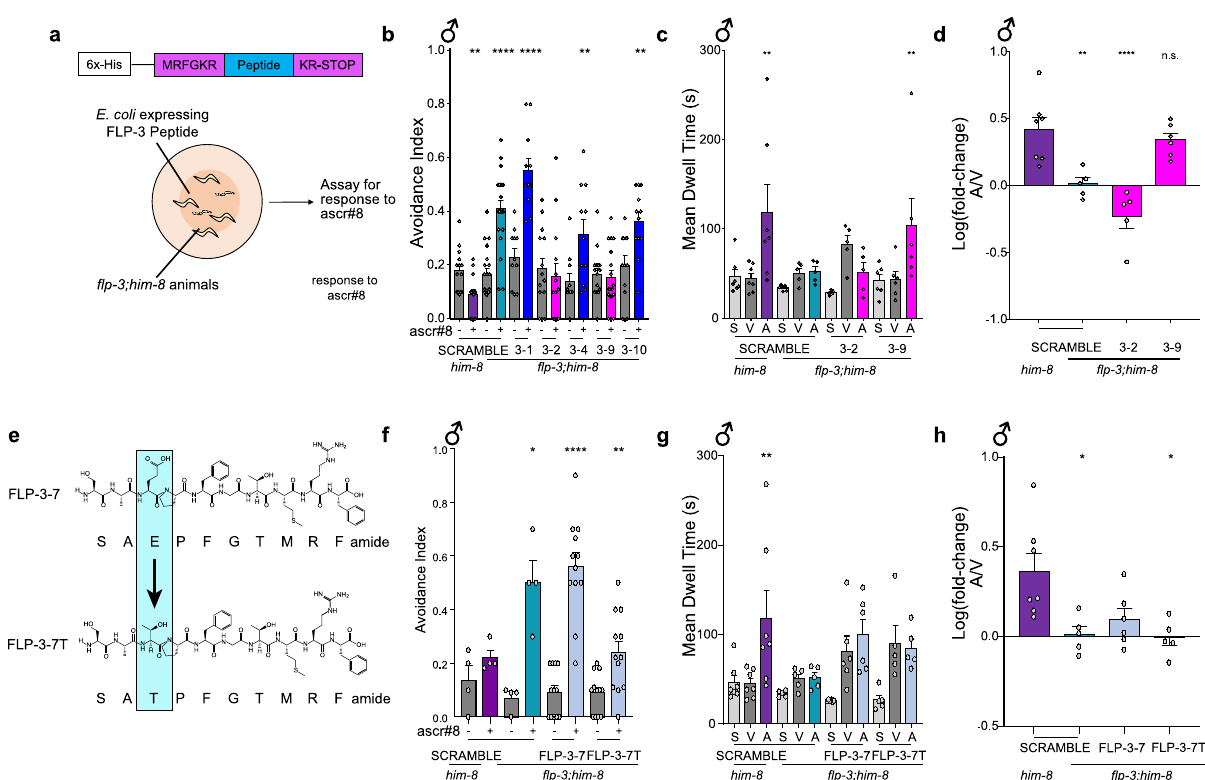
Fig. 6 Peptide feeding rescues wild-type behavior and reveals two active peptides within the FLP-3 precursor. a Overview of rescue-by-feeding paradigm: (Top) A plasmid in generated which encodes the peptide of interest is fl anked by EGL-3 cleavage sites, with a 6x-His tag upstream. (Bottom) fl p- 3 lof animals are raised on bacteria expressing the FLP-3 peptide of interest for 72-96 h and are assayed as young adults. b Avoidance behavior of him-8 and fl p-3 animals raised on scramble peptide or speci fi ed FLP-3 peptides. him-8 and fl p-3 males fed SCRAMBLE display their characteristic avoidance to ascr#8. fl p-3 males fed peptides FLP-3-2 or FLP-3-9 restore avoidance to wild-type levels. c , d fl p-3 male animals fed FLP-3-9 peptides rescues attraction behavior to ascr#8 c Raw dwell time and d log(fold-change) values for him-8 and fl p-3 males fed peptides FLP-3-2 or FLP-3-9. e Mutational schematic of FLP-3-7 to generate FLP-3-7T: the glutamate ( “ E ” ) in position 9 was mutated to a threonine ( “ T ” ). f fl p-3 lof male animals raised on FLP-3-7T suppress avoidance to ascr#8 suggesting the importance of amino acid threonine in mediating avoidance. g, h fl p-3 animals raised on FLP-3-7 and FLP-3-7T display no rescue of attractive behavior to ascr#8. g Raw dwell time and h log(fold-change) of fl p-3 animals raised on FLP-3-7 and FLP-3-7T. ♂ denotes male